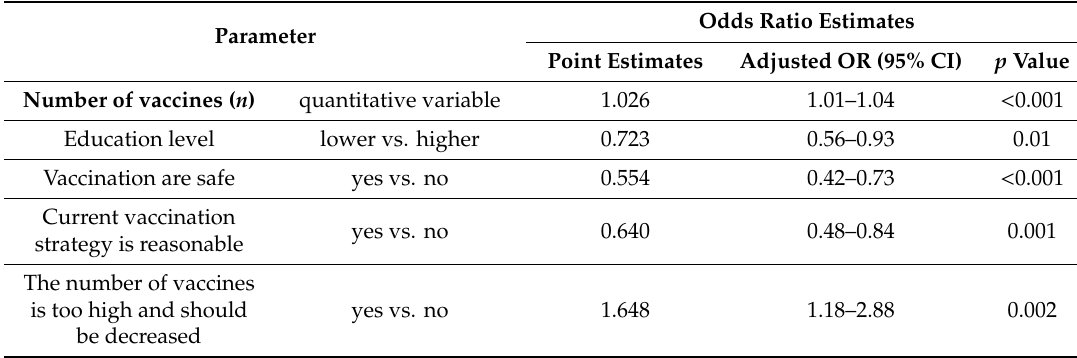
Table 3. Stepwise logistic regression model for AEFI prediction ( n =